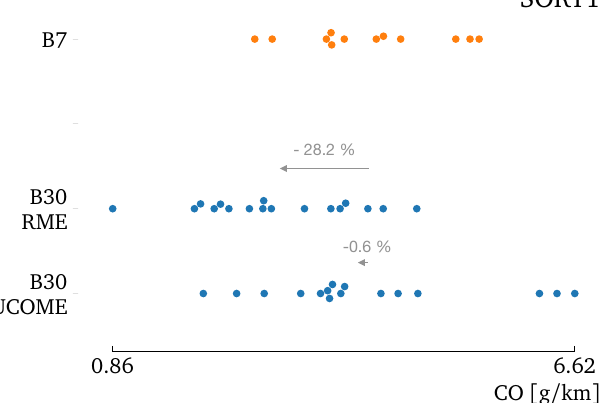
Figure 14. No considerable difference in CO emissions is measured between B30 RME, B30 UCOME and B7 during SORT 1 test runs. The emission rates are low and close to the accuracy of the CO measurement